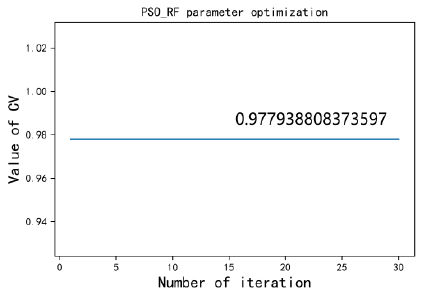
Figure 11. Random forest tuning effect.